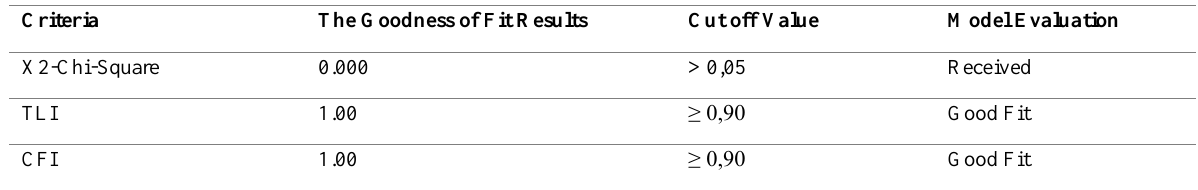
Table 5: Test of Goodness of